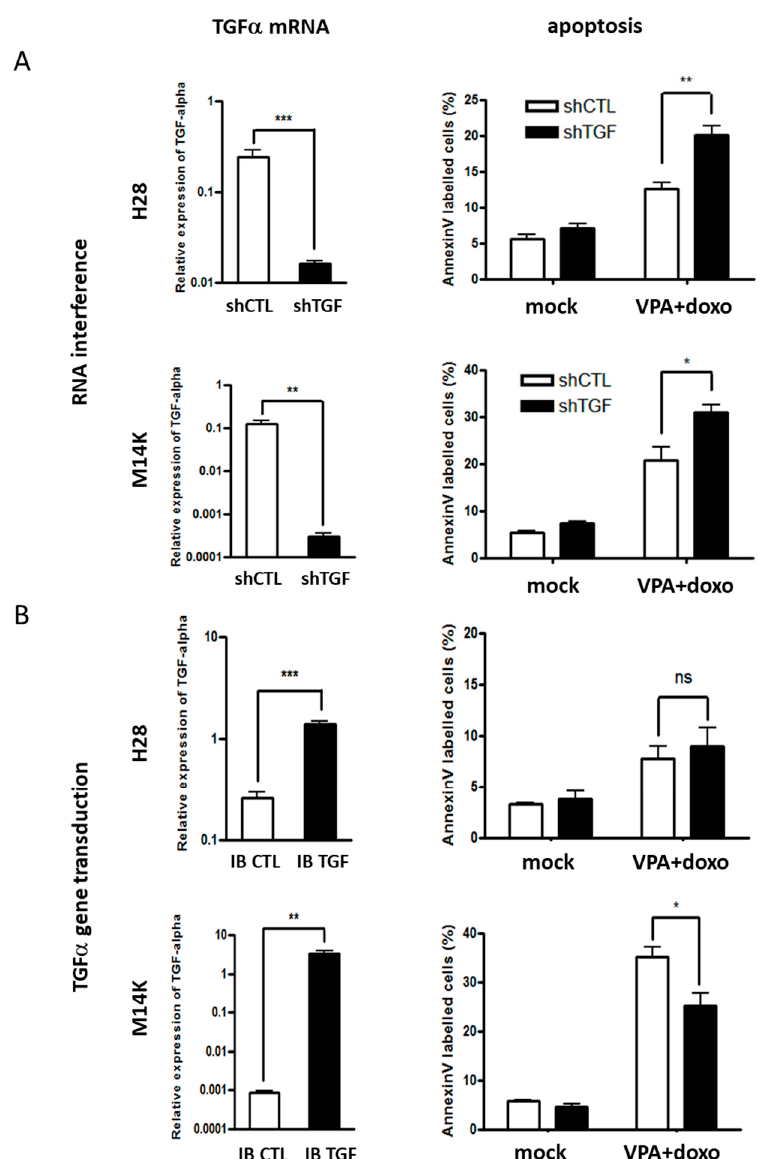
Figure 2. RNA interference and overexpression of TGF α increases and reduces the apoptosis induced by VPA and doxorubicin, respectively. ( A ) TGF α expression was inhibited in H28 and M14K cells by RNA interference using shRNA cloned into pLKO.1 (shTGF). A scrambled shRNA was used as control (shCTL). Downregulation or increased expression of TGF α was confirmed by RT-qPCR (left panels). The HPRT gene transcript was used as an endogenous control to calculate the relative expression of TGF α . Expression levels are represented as means ± SD of at least three independent experiments. Statistical significance was evaluated with the Mann–Whitney U test. The apoptosis induced by VPA-doxorubicin (VPA + doxo) was measured by an Annexin V assay (right panels). Apoptosis rates were calculated from three independent experiments and are represented as means ± SD. Means were compared using the independent Student’s t-test. * p -value < 0.05; ** p -value < 0.01; *** p -value < 0.001; ns: not significant. ( B ) TGF α was overexpressed in H28 and M14K cells using the plasmid pCSEF-IB-TGF α (IB TGF), while the empty vector pCSEF-IB served as control (IB CTL). TGF α expression and apoptotic rates were determined as described in panel A .